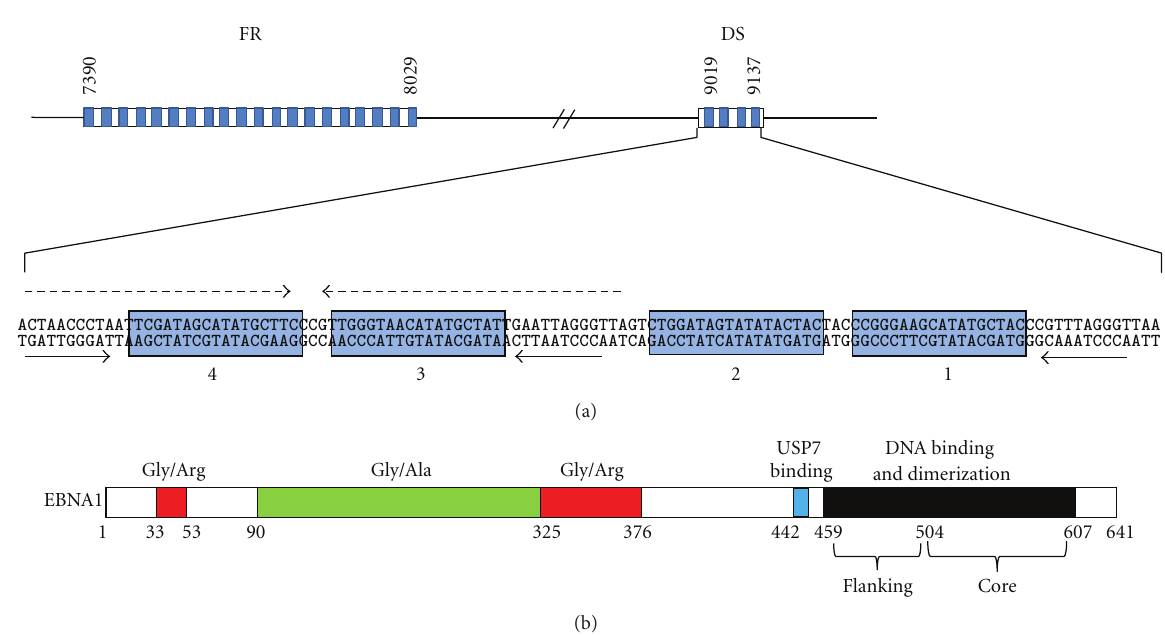
F 1: Schematic representation of oriP and the EBNA1 protein. (a) Organization of the oriP DS and FR elements showing genome nucleotide coordinates and EBNA1 binding sites (blue boxes). For the DS element, the positions of the four EBNA1-binding sites (numbered blue boxes), 65bp dyad symmetry sequence (broken arrows), and nonamer repeats (solid arrows) are indicated. (b) Organization of the EBNA1 protein showing the two Gly-Arg-rich regions (red), Gly-Ala repeat (green), USP7-binding site (blue), and DNA binding and dimerization domain (black). Amino acids numbers are indicated